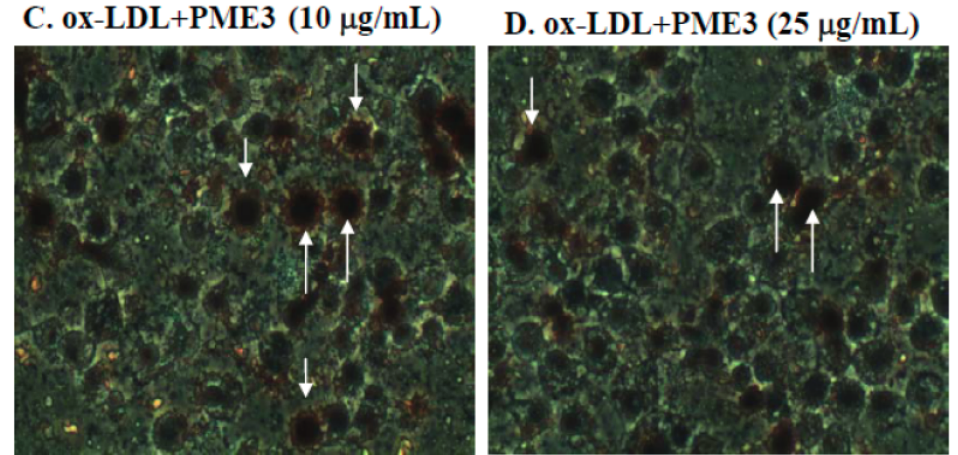
Figure 3. Effects of Pinus morrisonicola extract fraction 3 (PME3) on foam cell formation in RAW 264.7 macrophages incubated with ox-LDL for 24 h. ( A ): RAW 264.7 cells treated with